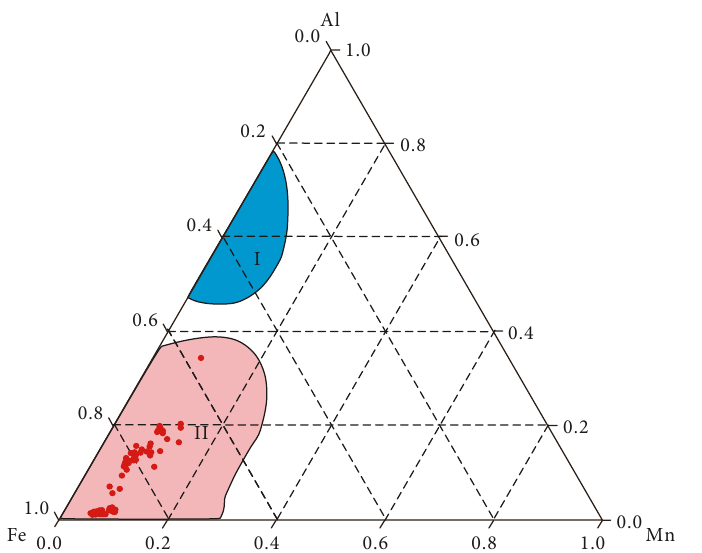
Figure 7: Al-Mn-Fe content and origin analysis diagram for the siliceous minerals from the upper Ordovician Xinkailing Formation-lower Silurian no. 1 member of the Lishuwo Formation in the Y-1 well. The values of excess silicon are nearly all in the hydrothermal zone, indicating that the excess silicon is derived from a hydrothermal origin. The base map is from Wedepohl [20], Adachi et al. [21], and Yamamoto [22]. See Figure 1 for the well location. I: bio-origin; II: hydrothermal